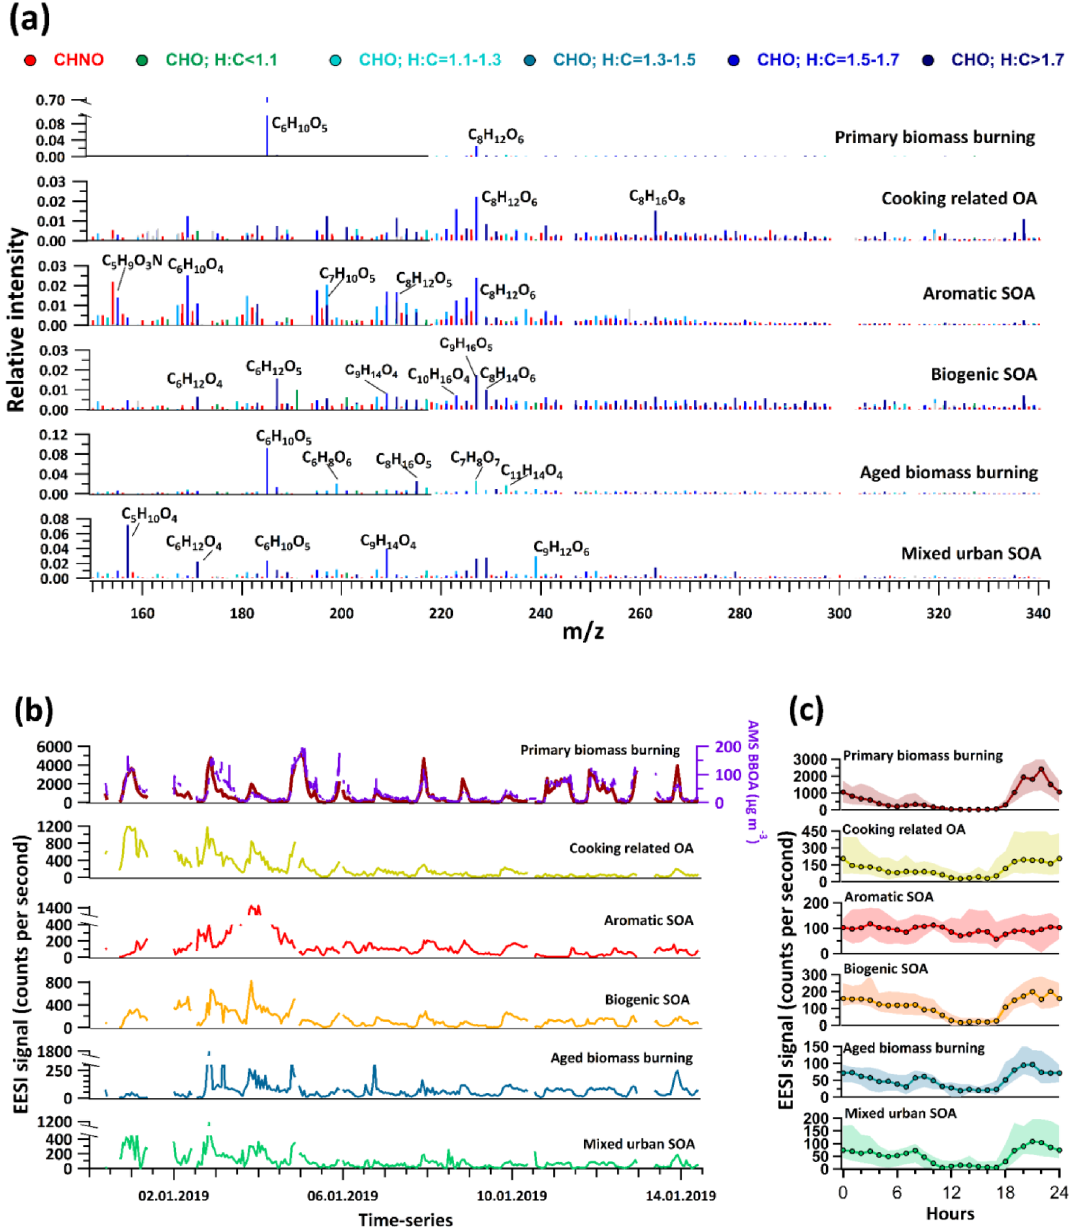
Figure 2. (a) Factor mass spectra of EESI-TOF PMF analysis. The green-to-blue colour gradient represents C x H y O z compounds classified by their H : C ratio as mentioned in the legend, while red denotes C x H y O z N 1 − 2 compounds. (b) Factor time series, together with selected external species for comparison. (c) Diurnal variations in the EESI-TOF factors with an hourly resolution. Shaded areas show interquartile